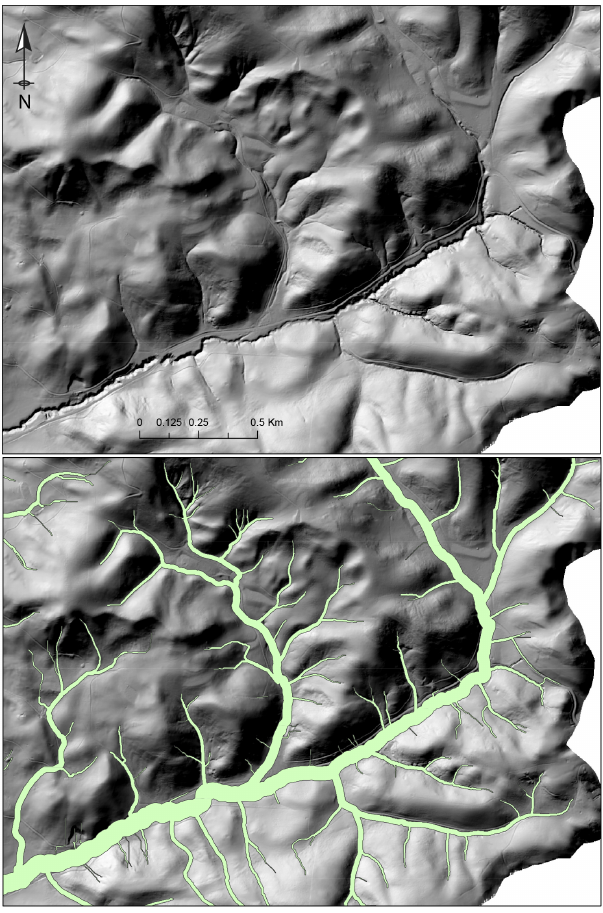
Figure 3. Example of the buffer used to define the sediment source area from incised channels in the upper Arroyo Seco